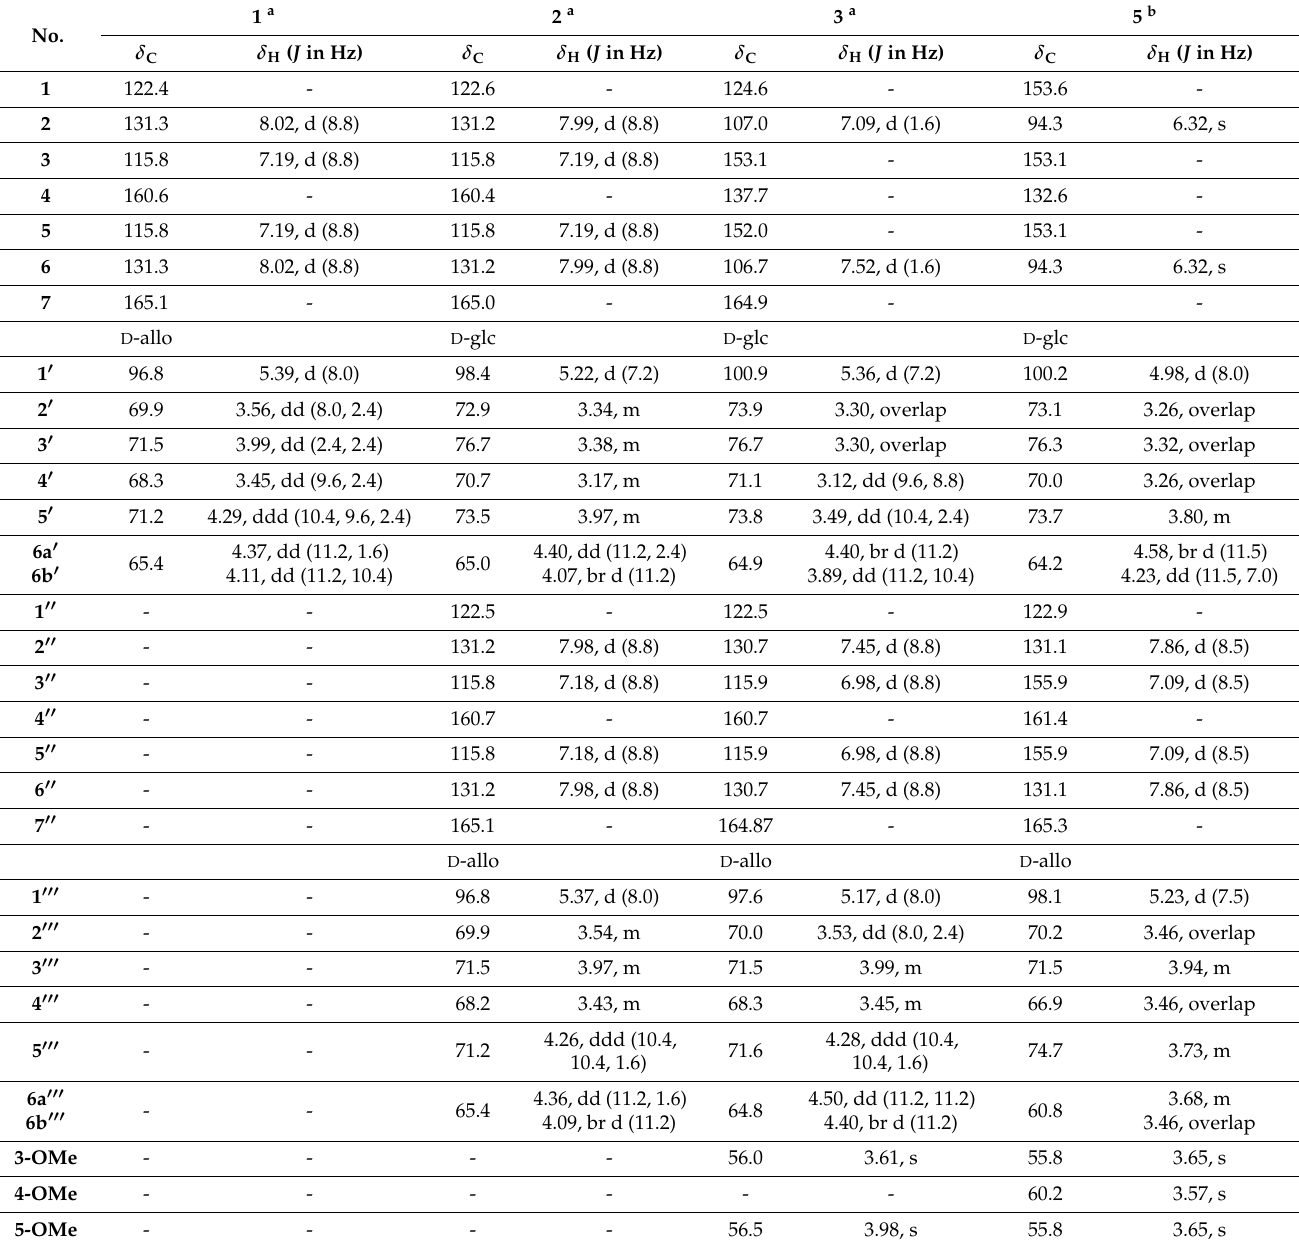
(Figure 2 and Table 1). These results were further confirmed by comparison of the NMR chemical shifts with those reported [26,27,30]. The two sugar units were finally determined to be in the D -form through derivatization of the afforded sugar by acid hydrolysis of 2 [29]. The linkages of the two 4-hydroxybenzoyl groups, β - D -allopyranoside, and β - D - glucopyranoside were established by the observed HMBC correlations from H-1 (cid:48)(cid:48) to C-4, from H-1 (cid:48)(cid:48)(cid:48) to C-4 (cid:48)(cid:48) , from H-6a (cid:48) /H-6b (cid:48) to C-7 (cid:48)(cid:48) , and from H-6a (cid:48)(cid:48) /H-6b (cid:48)(cid:48) to C-7 (cid:48)(cid:48) (Figure 2). In the ROESY spectrum, cross-peaks of H-3, 5 with H-1 (cid:48) and H-5 (cid:48) and H-3 (cid:48)(cid:48) , 5 (cid:48)(cid:48) with H-1 (cid:48)(cid:48)(cid:48) and H-5 (cid:48)(cid:48)(cid:48) appeared, indicating that 2 is a macrocyclic glycoside (Figure 3). Thus, the structure of 2 was elucidated as 4-({6 (cid:48) - O -[(4 (cid:48)(cid:48) - O - β - D -allopyranosyl)hydroxy-benzoyl]- β - D - glucopyranosyl}oxy)hydroxyl-benzoic acid inner ester and named as heliciopside B. Table 1. 1 H- and 13 C-NMR spectroscopic data of compounds 1 – 3 and 5 in DMSO- d 6